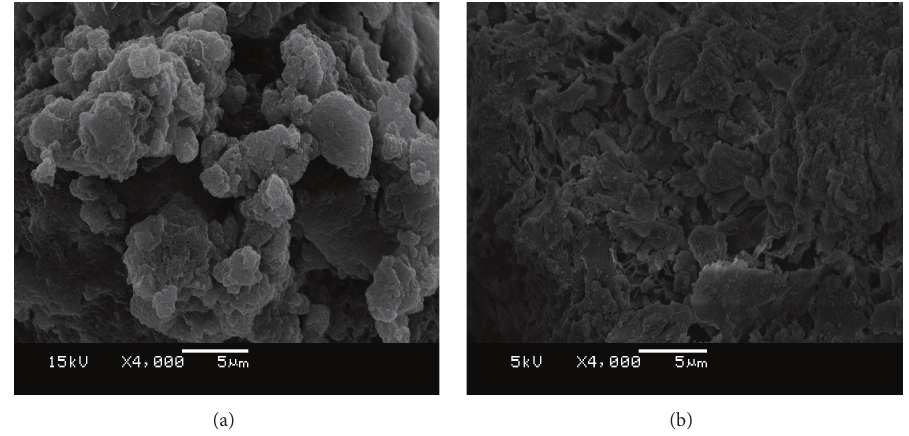
Figure 2: SEM images of (a) Oil-g-CF and (b) Silane-g-CF.